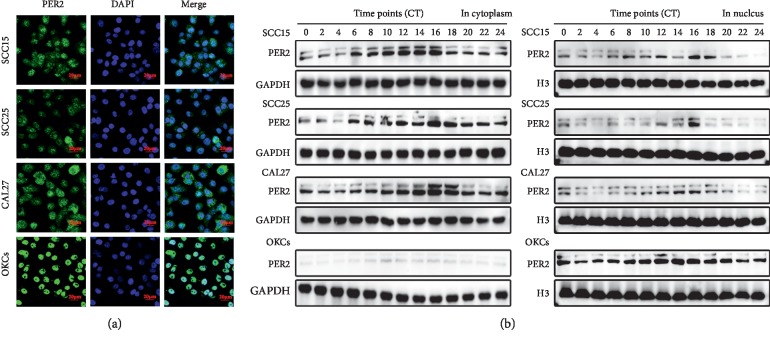
PER2 expression is remarkably downregulated and its nuclear translocation is blocked in OSCC cells. (a) Immunofluorescence staining for PER2 (green) in three OSCC cell lines and OKC cells. Nuclei were stained by DAPI (blue). (b) The PER2 protein expression levels of three OSCC cell lines in both cytoplasm and nucleus at each time point.